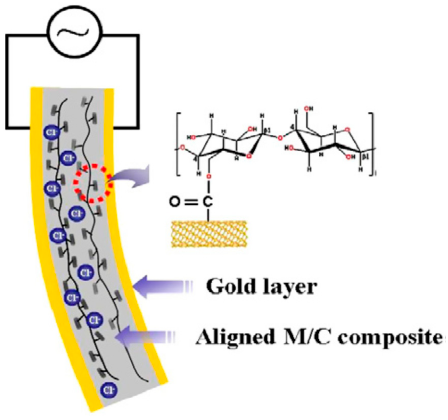
Figure 5. Schematic structure of aligned M/C composite actuator [48].